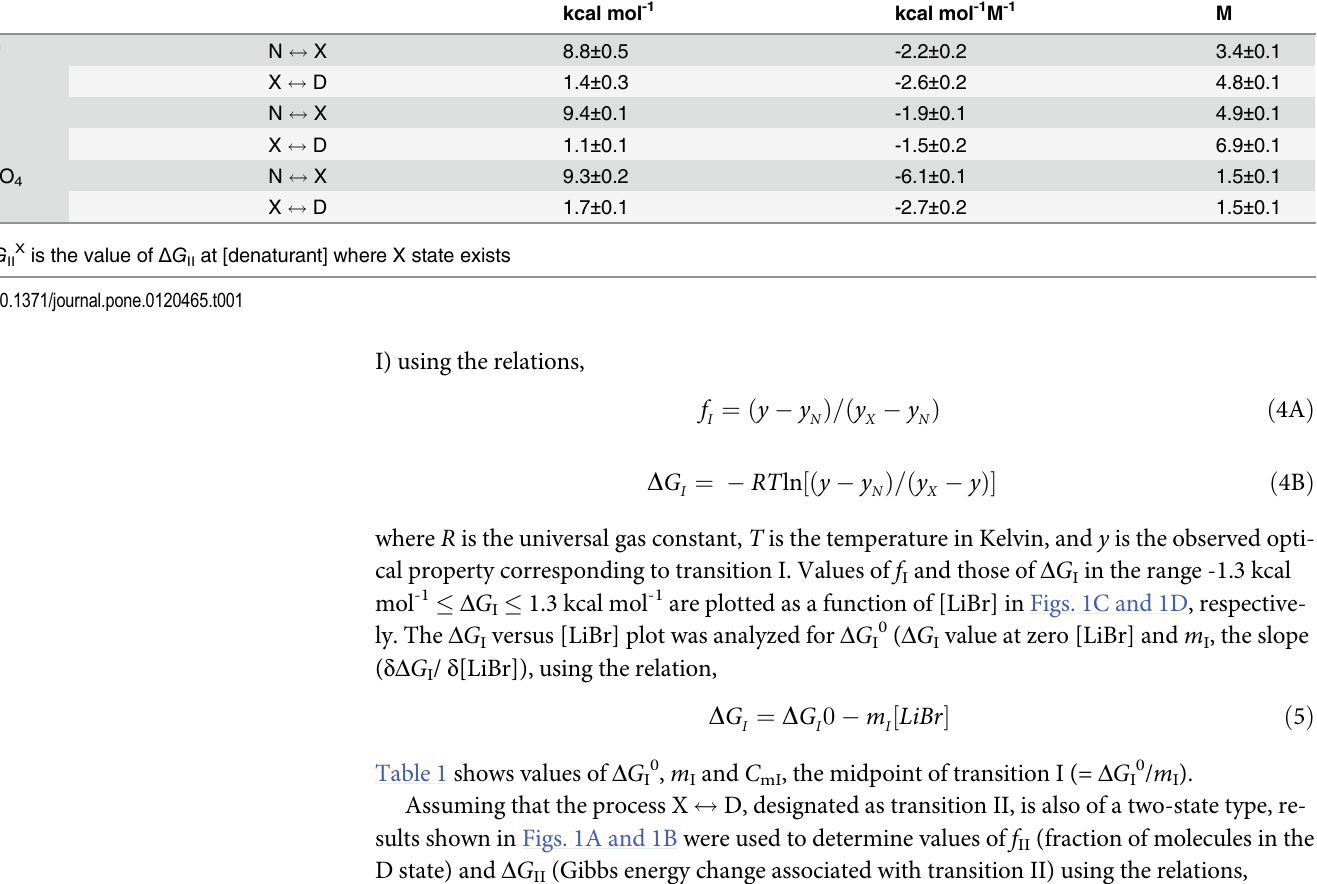
Table 1. Thermodynamic parameters characterizing the weak salt denaturants-induced denaturations of cyt- c at pH 6.0 and 25 ± 0°C.